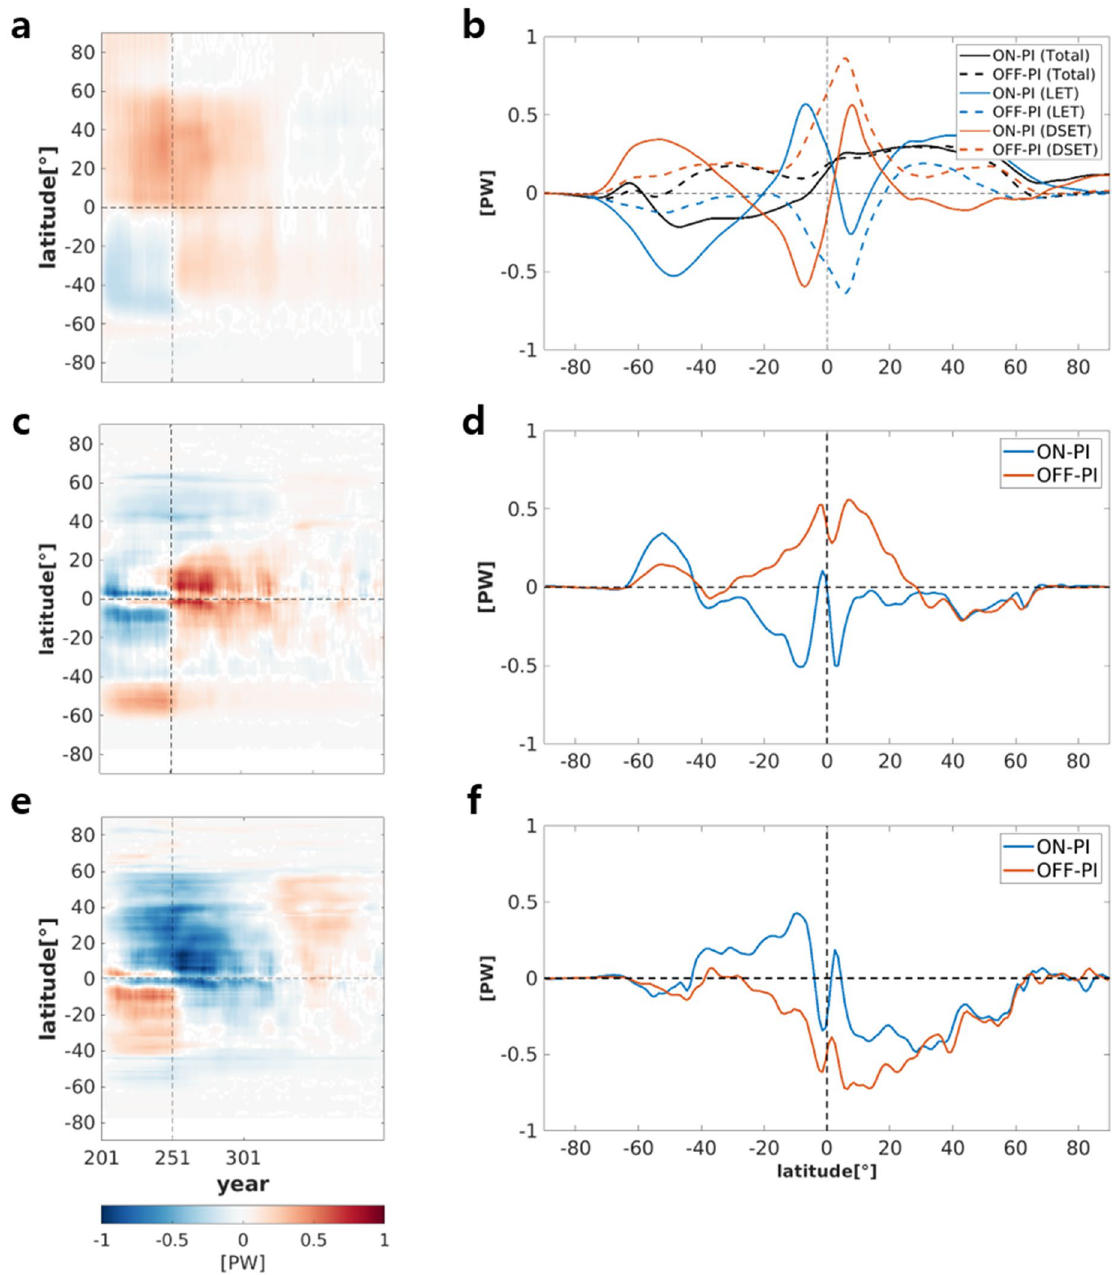
Figure 4. Hovmöller diagram of zonally-averaged ( a ) atmospheric heat transport (AHT), ( c ) upper oceanic heat transport (OHT) and ( e ) lower OHT deviations from the mean of PI experiment. Differences in time-mean for ( b ) AHT, dry static energy (DSET), and latent energy transport (LET), ( d ) upper OHT and ( f ) lower OHT between the ON50Y (OFF50Y) and mean of PI experiment. Units are Petawatts. ON and OFF indicates ON50Y and OFF50Y,